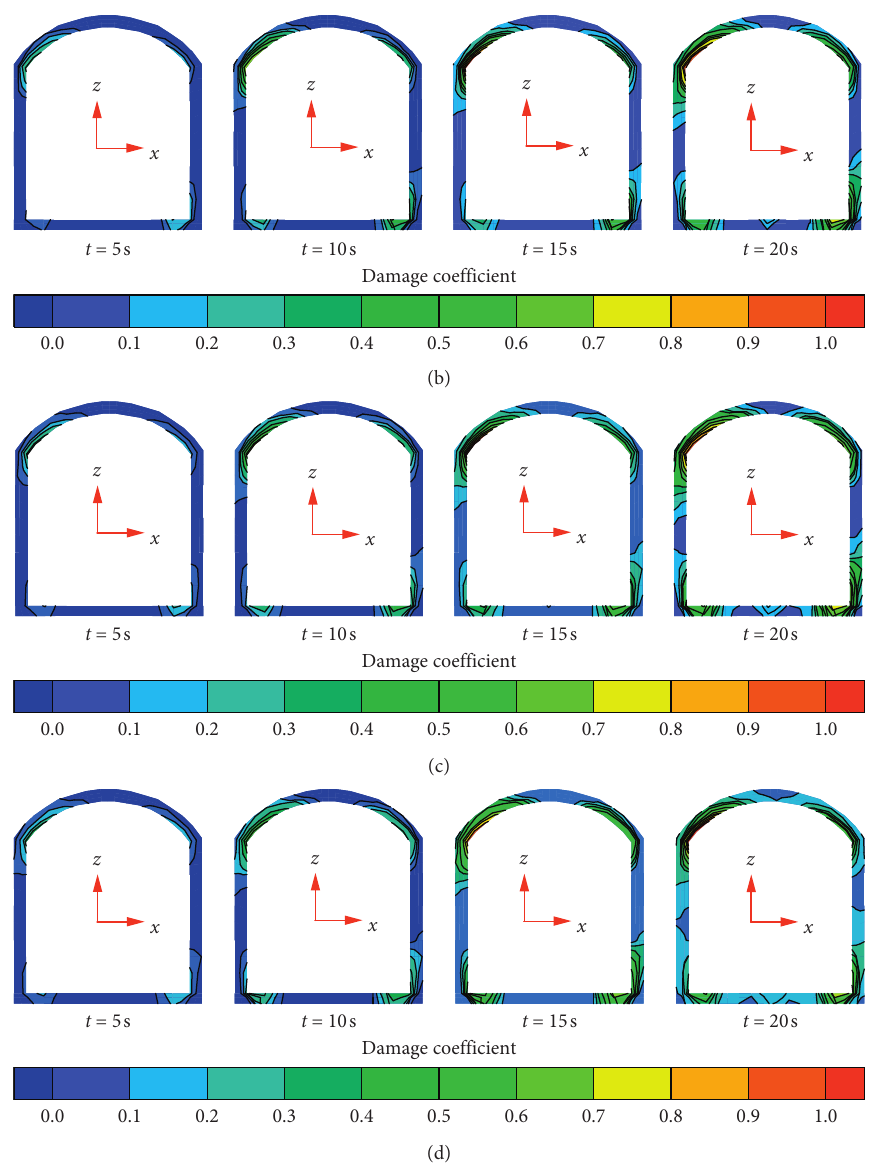
Figure 12: Damage coefficients of the tunnel under different input angles: (a) 0 ° input angle; (b) 10 ° input angle; (c) 20 ° input angle; (d) 30 ° input